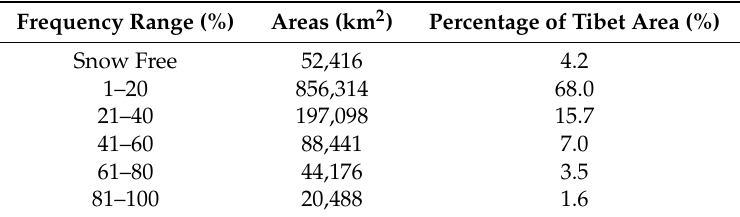
Table 1. Areas and percentage of the total area of Tibet for the different frequency ranges of snow cover during 2001–2015.